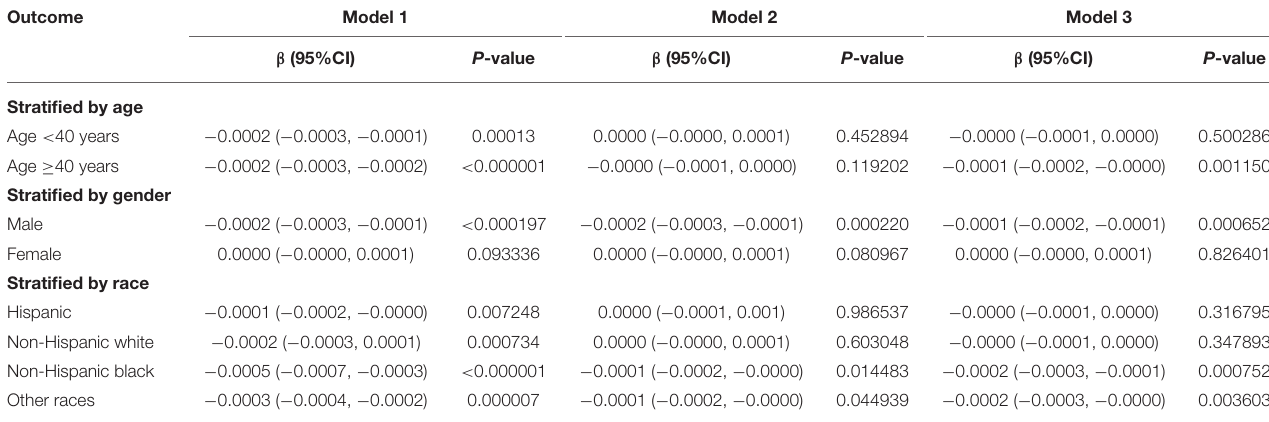
TABLE 3 | Relationship between ferritin and ASMI.